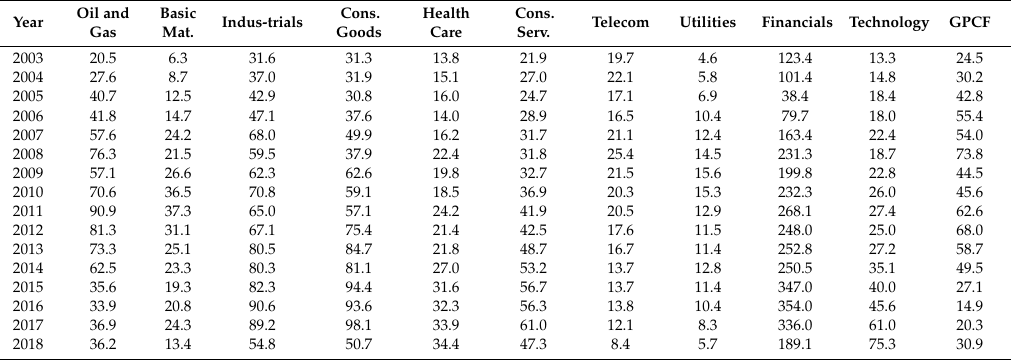
Table 5. Operating cash flows for each ICB industry 2003–2018, weighted by the GPFG industry weights. The last column shows the Norwegian government’s petroleum cash flow. USD billions. Year Oil and Gas Basic Mat. Indus-trials Cons. Goods Health Care Cons.